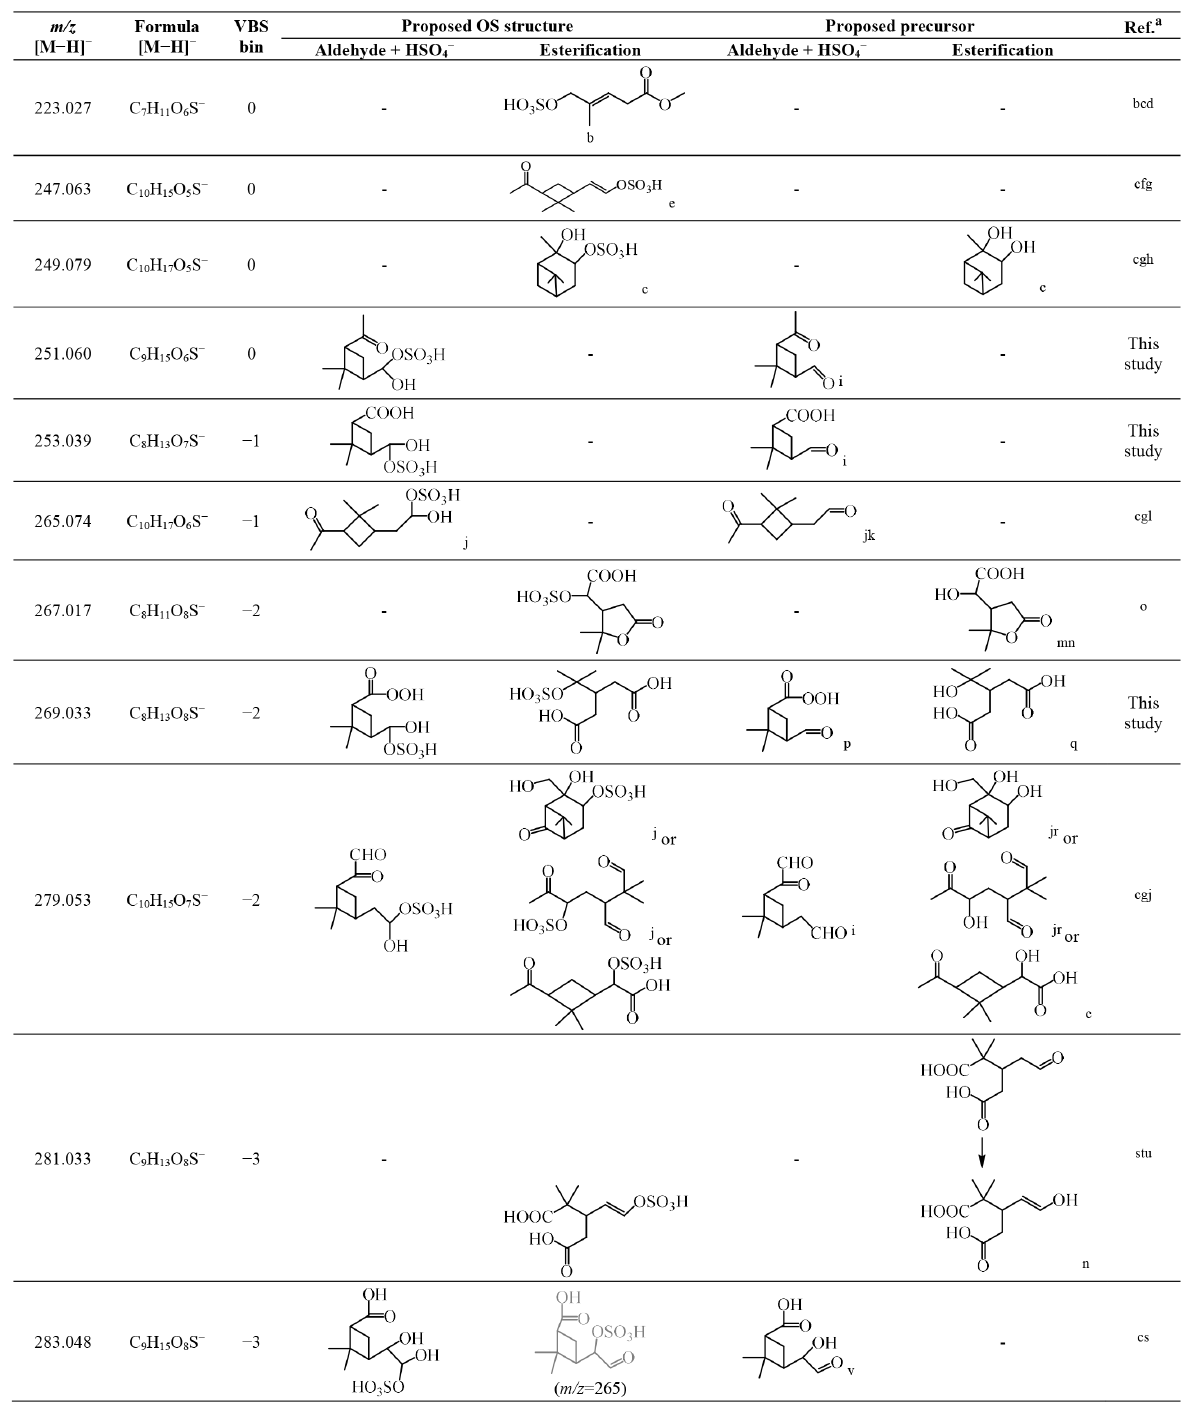
Table 3. Organosulfates identified in this study, their respective m/z and formula of [M − H] − , assigned VBS bin number, proposed OS structure, and proposed precursor oxidation product